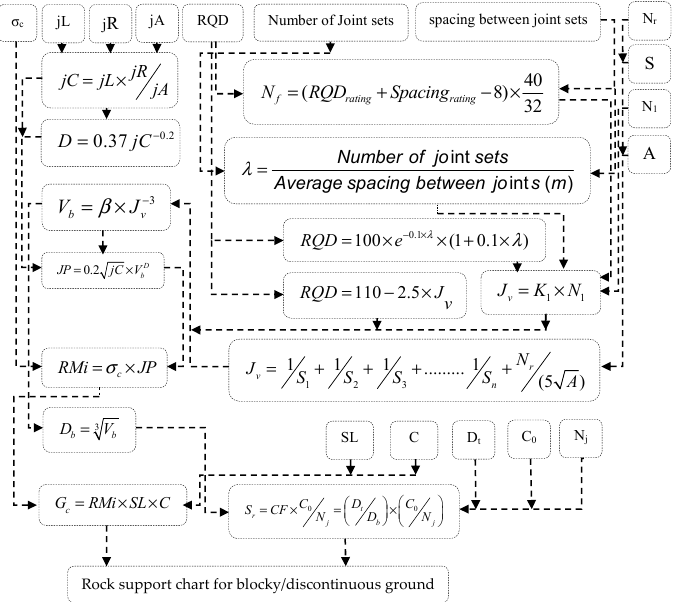
Figure 4. Flowchart for the tunnel support estimation using the RMi system in discontinuous ground.